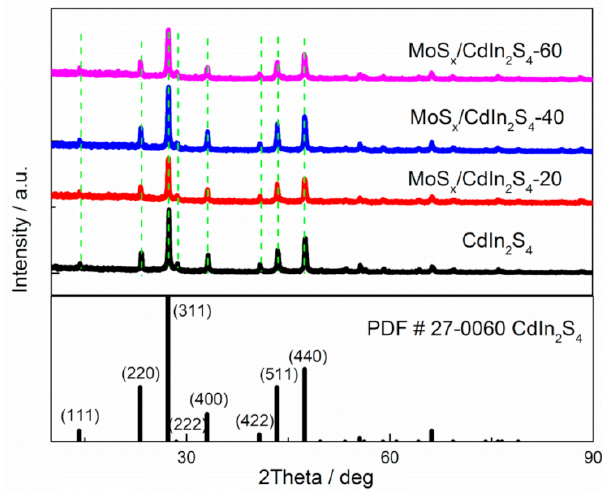
Figure 2. X-Ray Di ff raction (XRD) patterns of the as-prepared